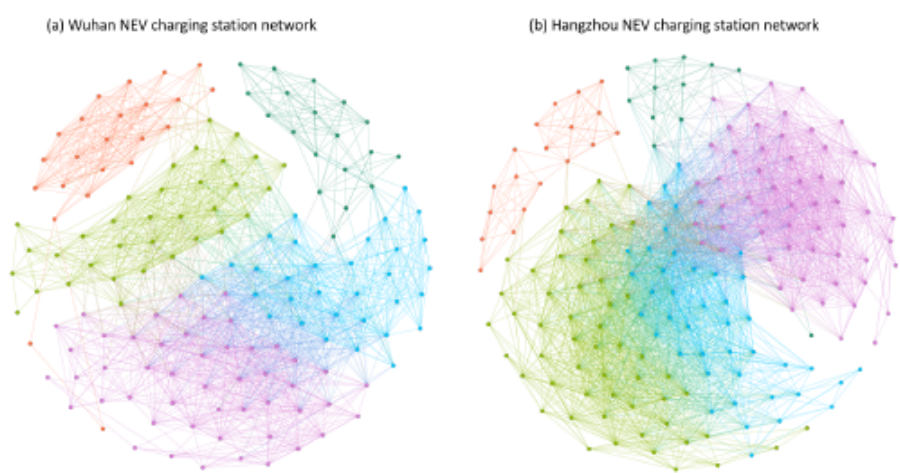
Figure 3. NEV charging station network in urban areas. ( a ) WNSN. ( b ) HNSN. The colors of the node indicate different